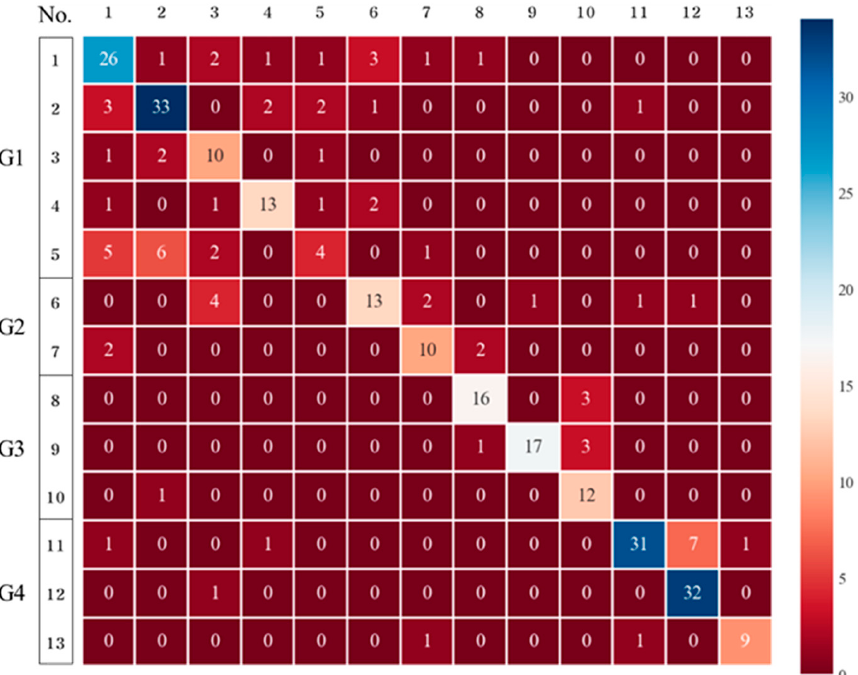
Figure 6. Confusion matrix (classi fi cation of the 13 chemicals using gradient boosting).